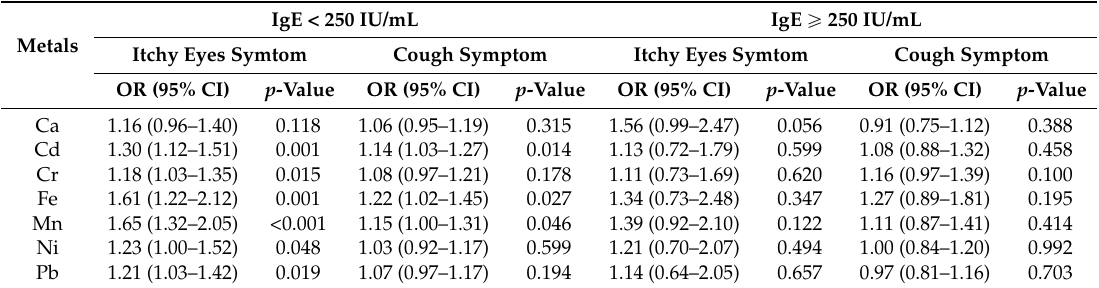
Table 4. Adjusted odds ratio and 95% confidence intervals for itchy eyes and cough symptom associated with level of heavy metals’ concentration at groups of patients with different total serum IgE